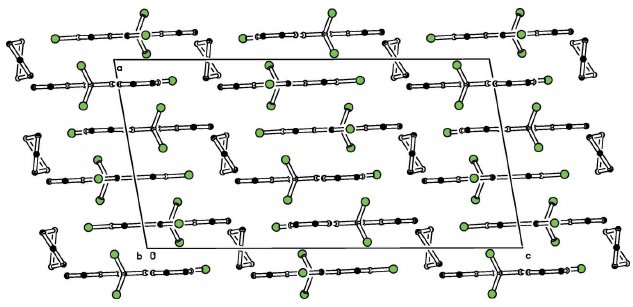
Figure 2 Part of the packing diagram. View along the b